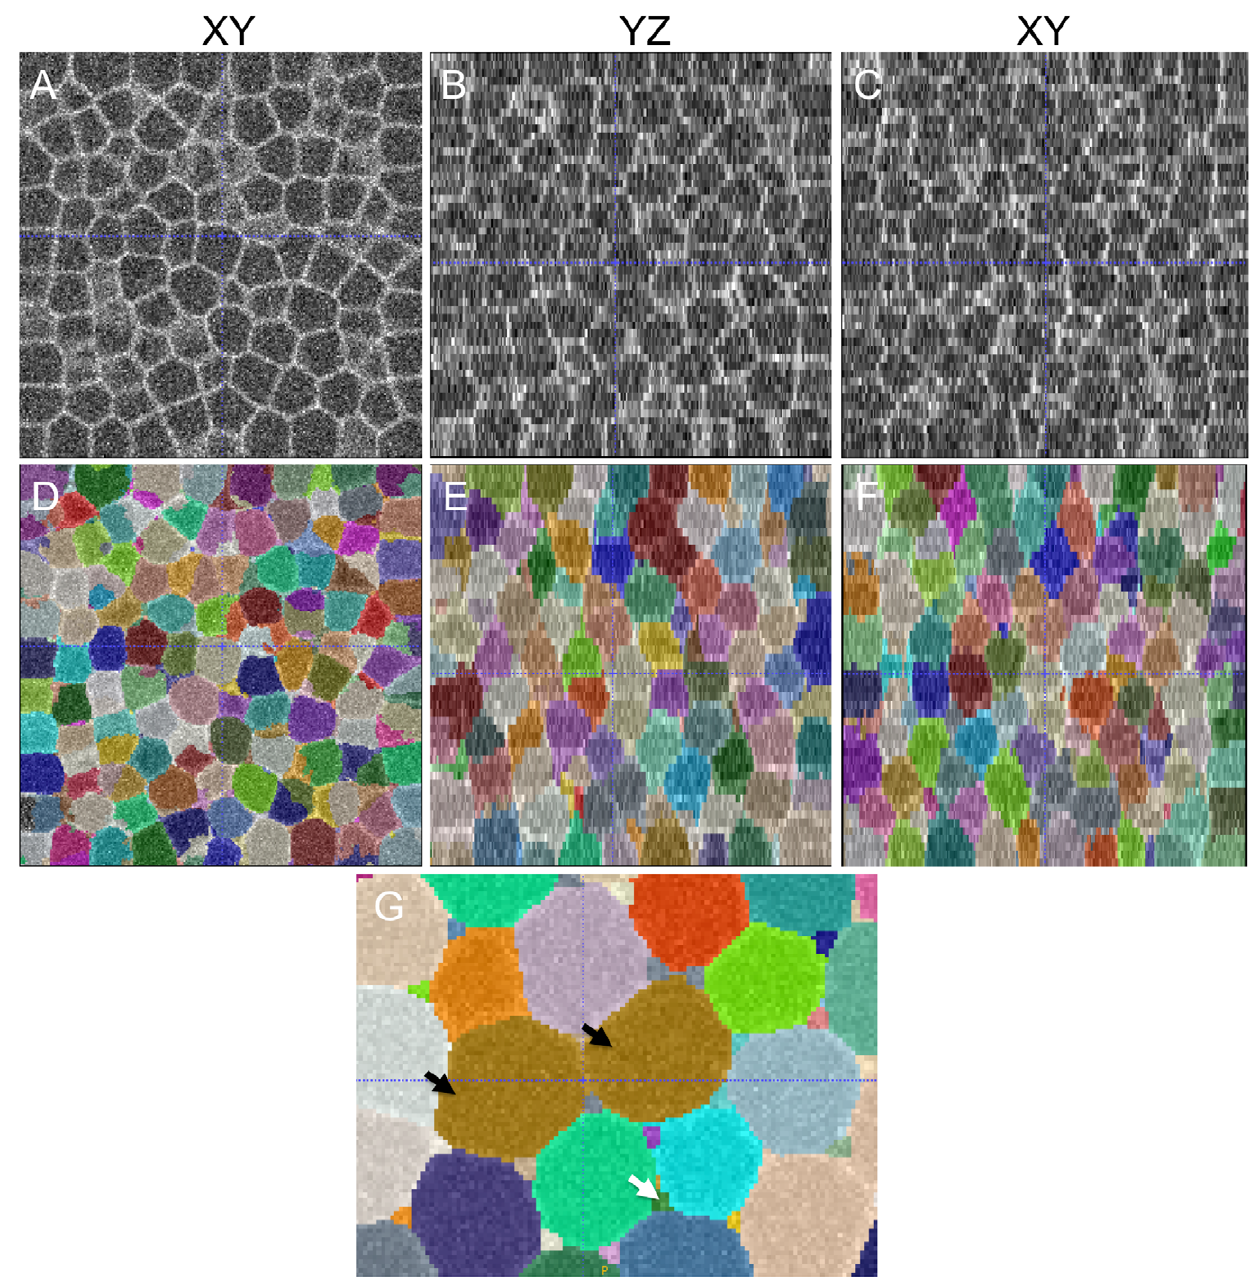
Figure 6. Accurate and highly-sensitive algorithm performance on synthesized 3D membrane images. (A–C) Synthesized cell structures in 3 D along XY , YZ and XZ sections with image noise added (Table 2). As in the case of real-world images, the lateral resolution significantly differs from the axial resolution. (D–F) Segmentations overlaid on the raw image with a 50% opacity function. (G) An example of under-segmentation (brown cells, black arrows) and over-segmentation (interstitial fragments, white arrows) in the image. The errors could be filtered out by size criteria.